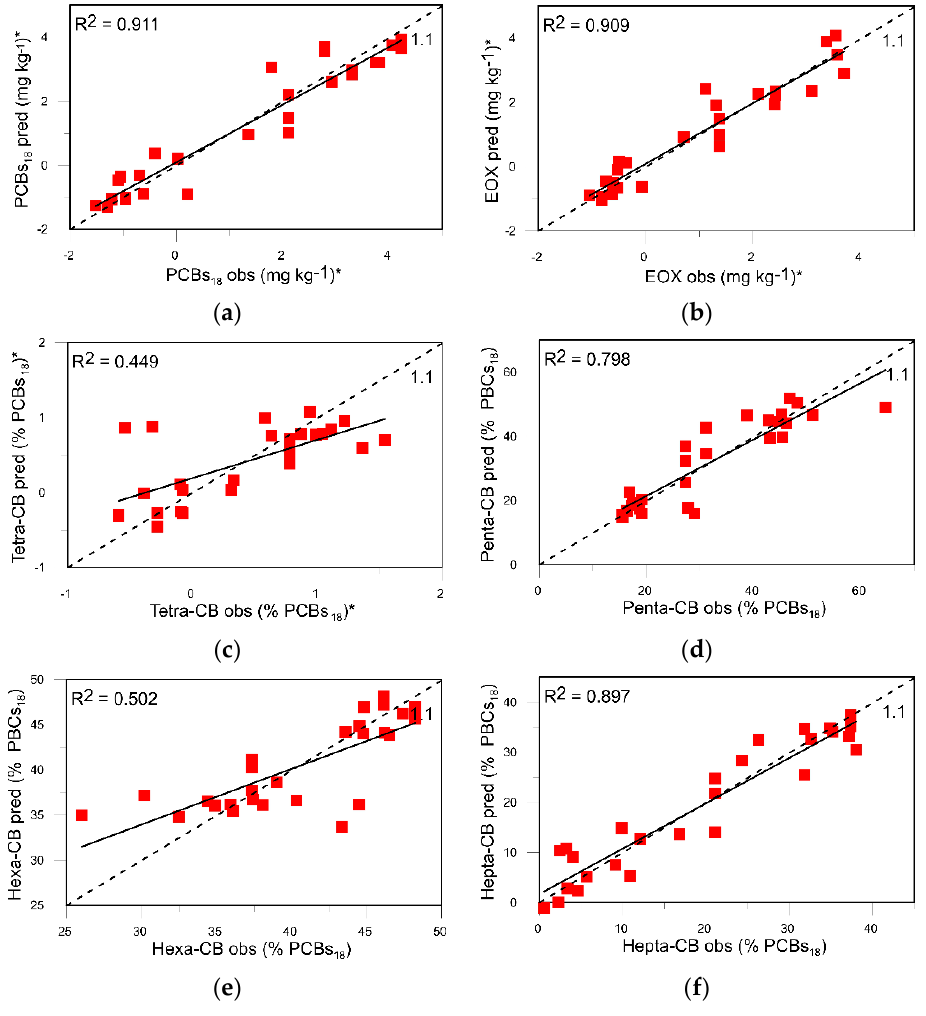
Figure 6. Plots of the measured against the predicted PCBs ( a ), EOX ( b ), Tetra-CB ( c ), Penta-CB ( d ), Hexa-CB ( e ), and Hepta-CB ( f ) contents based on PLSR models. The 1:1 line is indicated on each figure. * = log-transformed values.